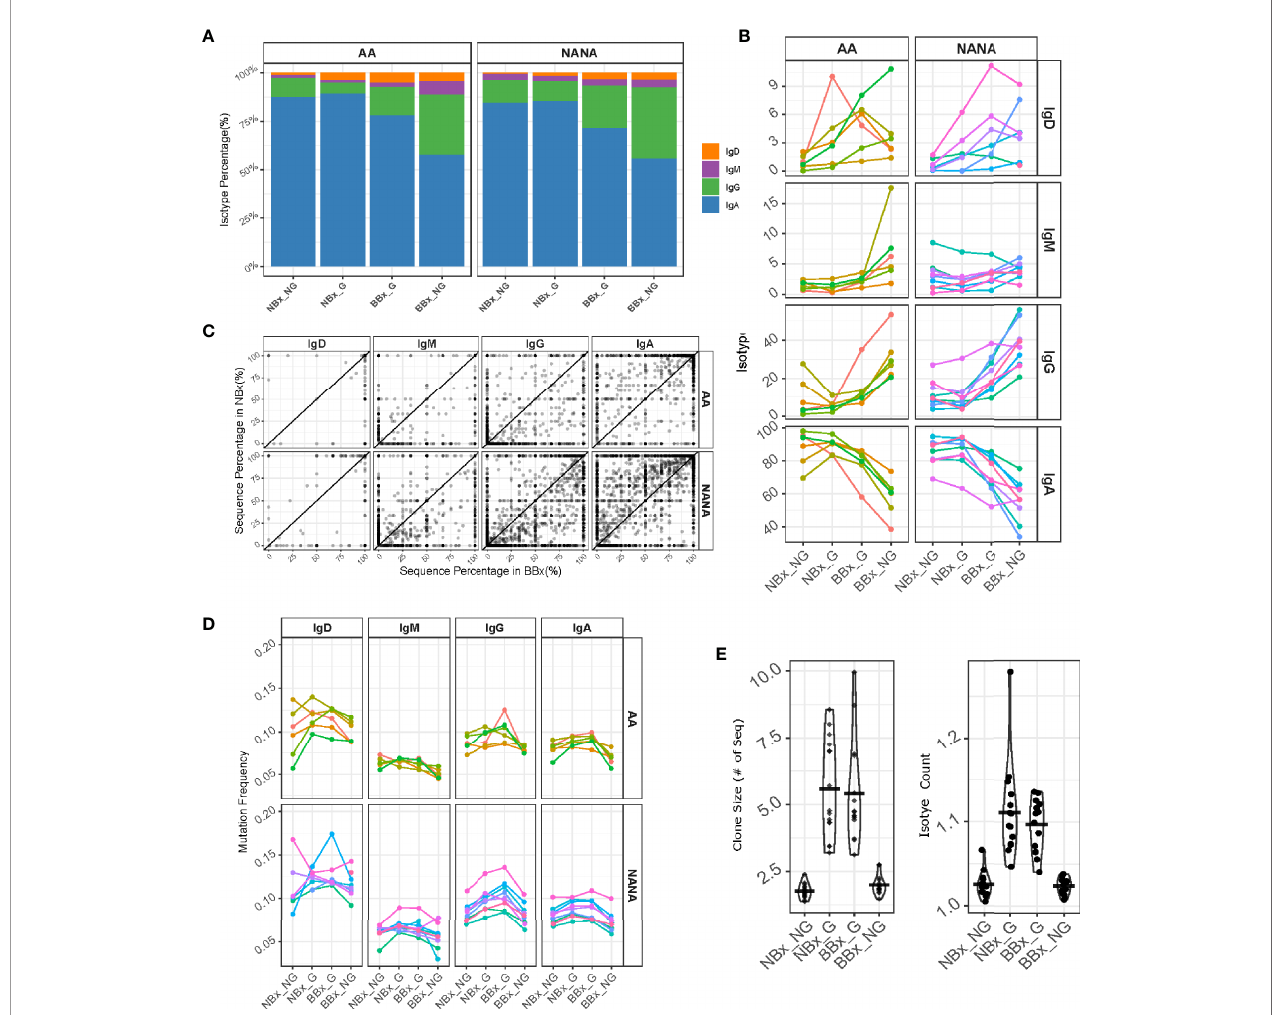
FIGURE 6 | B cells of all isotypes are able to traf fi c from the nasal to the bronchial mucosa. Global clones are de fi ned as those that contain both nasal and bronchial sequences. We divided the sequences into non-global nasal sequences (NBx_NG) – sequences from clones found in the nasal but not in the bronchial mucosa, global nasal sequences (NBx_G) – the nasal mucosal sequences from global clones, global bronchial sequences (BBx_G) – the bronchial sequences from global clones and non- global bronchial sequences (BBx_NG) – sequences from clones found only in the bronchial mucosa. (A) The percentages of the total number of sequences belonging to each isotype (IgD = orange, IgM = purple, IgG = green and IgA = blue) were plotted for each of the four sequence groups for atopic asthmatics (AA) or non-atopic, non- asthmatic controls (NANA). The percentages were calculated for each subject fi rst and then averaged for the asthmatics and non-atopic controls separately. (B) Linked changes in the percentage of each isotype from NBx_NG to NBx_G to BBx-G and BBx_NG were plotted for each individual (each line represents an individual, colored the same way as panel (D) . (C) For each global clone, corresponding to a data point in the plot, the percentages of sequences of a given isotype within the clone found in the nasal mucosa (y-axis) were plotted against the percentages of sequences from the bronchial mucosa (x-axis). (D) The mutation frequencies were plotted as the mean of the mutation frequency for sequences of a given isotype for each individual (each line represents an individual, colored the same way as panel (B) . (E) Left: mean clone size for a given cell subset in each subject for non-global and global clones from either the nasal or bronchial mucosa. Right: mean numbers of isotypes in a clone (right). Each point represents an